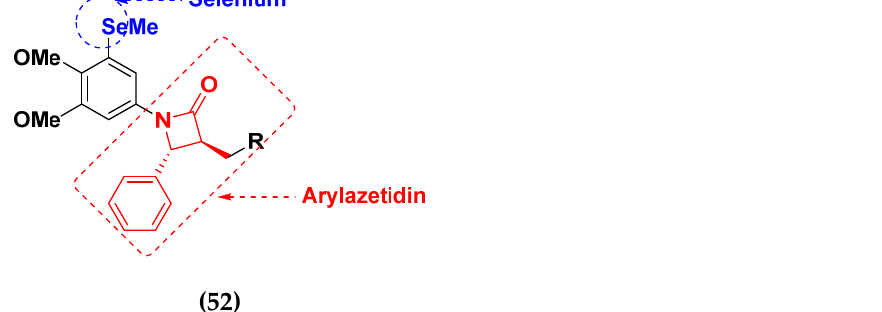
Figure 59. Structure of selenium based anilino quinazoline hybrid derivatives ( 52 ). Table 46. In vitro cytotoxic activities of selenium based anilino quinazoline hybrid compounds 52 ( a – d ). Comound No.